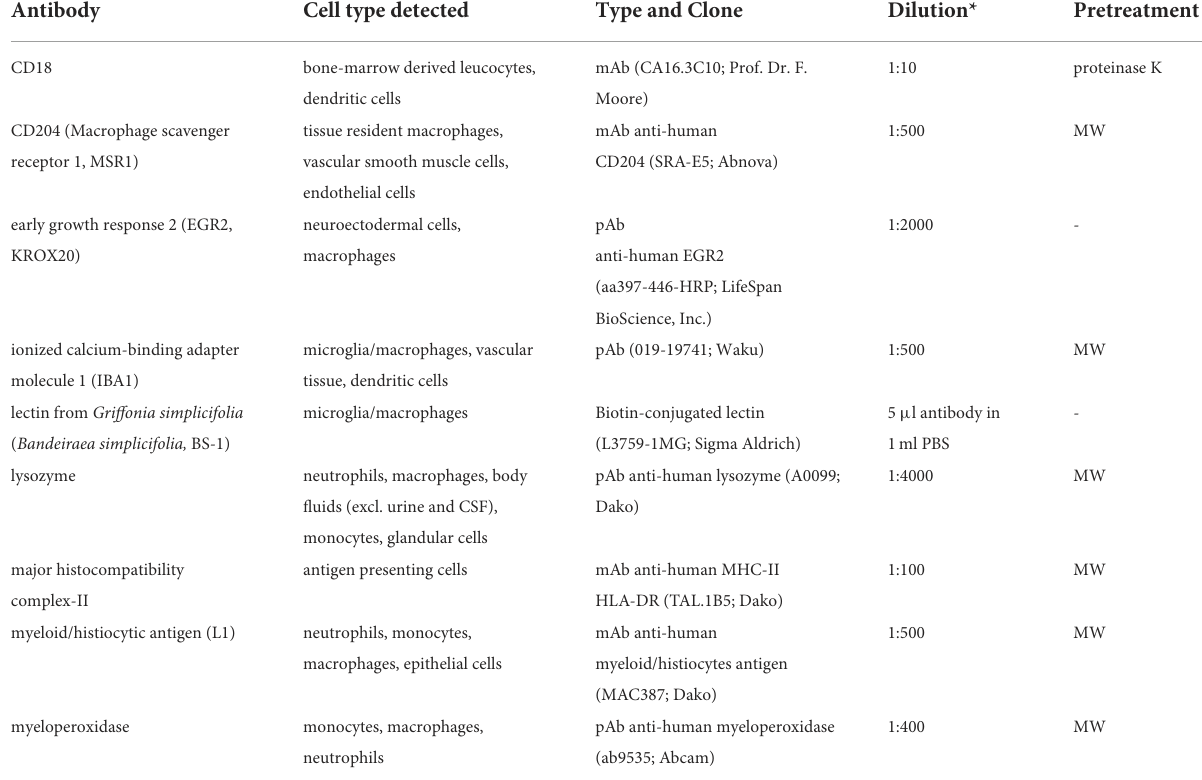
TABLE 2 Antibodies used for immunohistochemistry.